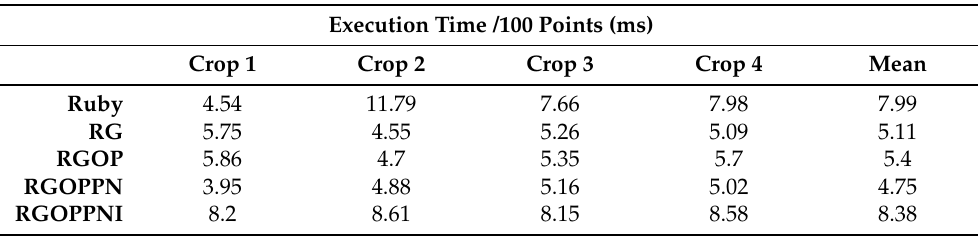
Table 6. The average execution time per 100 points for the line finding algorithms (LiDAR data to models) during the 500 first iterations of each